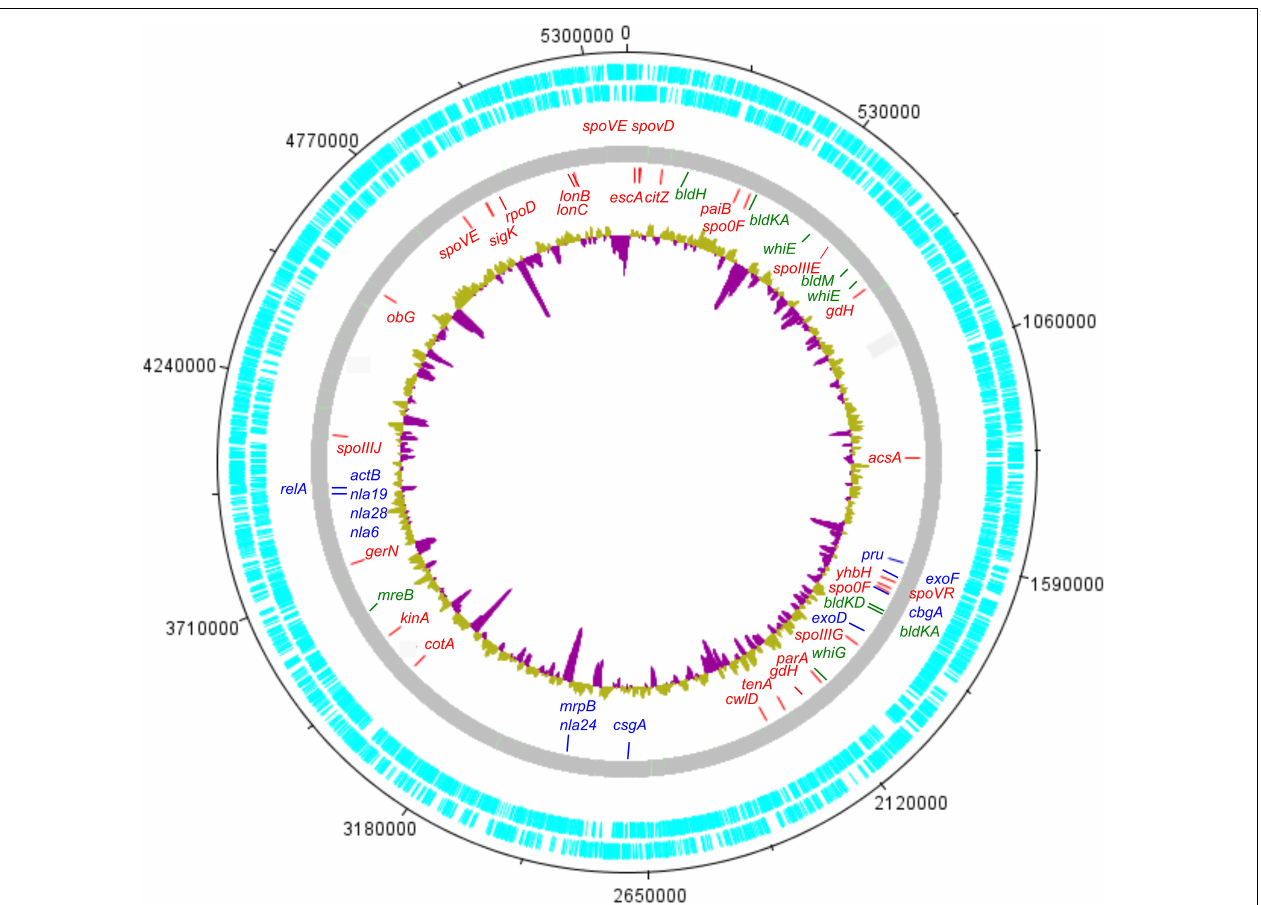
FIGURE 3 | Circular representation of the S. ureilytica Lr5/4 genome. Genes related to sporulation are spread throughout the chromosome. Genes indicated in red show homology to genes related to endospore-formation in Firmicutes, in blue to myxospore-formation in delta-Proteobacteria and in green to exospores in Actinobacteria. The inner circle in yellow (A+T%) and purple (G+C%) represents the G+C% content variation throughout the bacterial